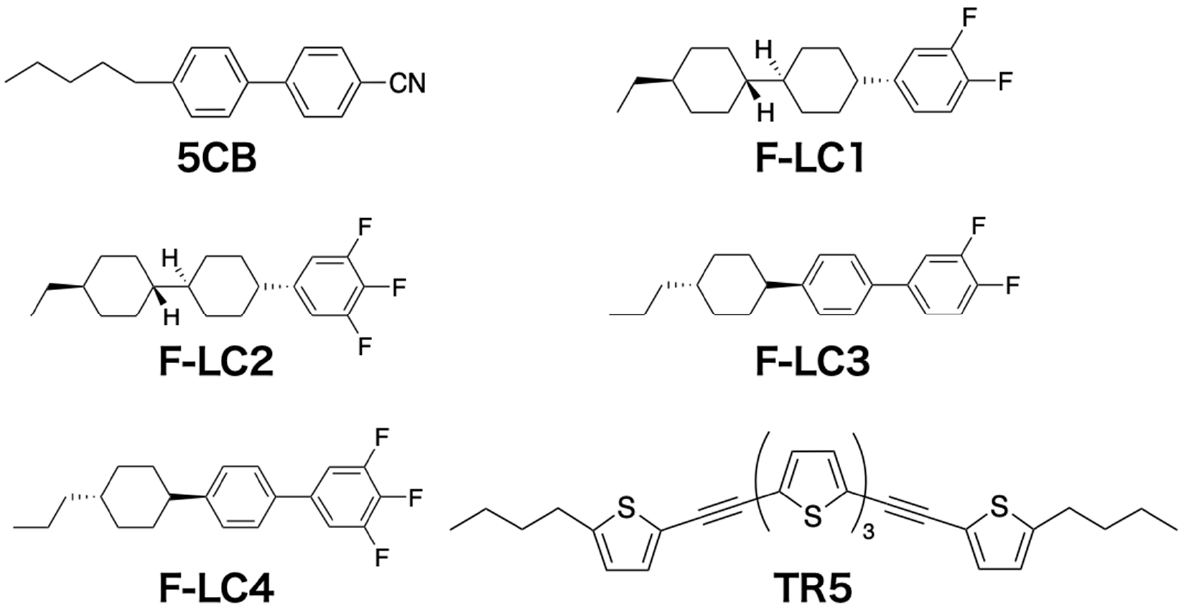
Figure 1. Chemical structures of the compounds used in this study. Pure 5CB or mixtures of 5CB and F-LCx (5CB:F-LCx = 75:25, molar ratio) were mixed with a TR5 solution (0.01 mol/L in tetrahydrofuran (THF)) in brown vials, diluted in